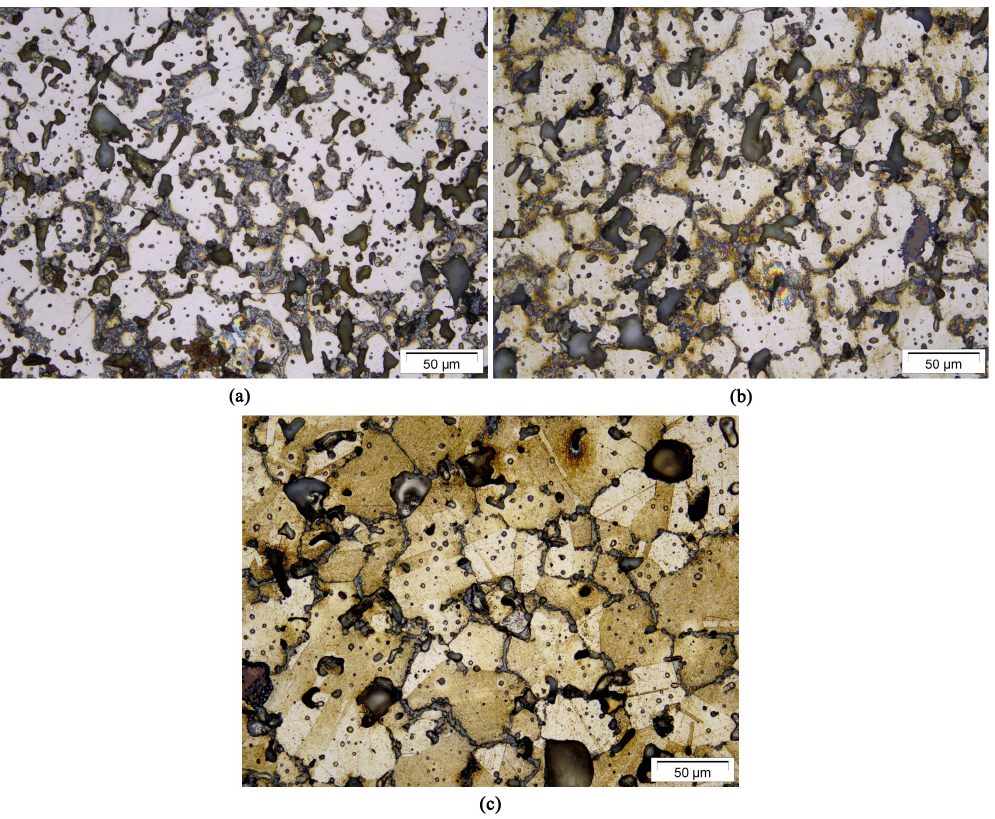
Figure 4. Microstructural characterization (core areas) of Hadfield steel sintered samples processed at 1150 °C (a), 1200 °C (b) and 1250 °C (c). Author: Renan